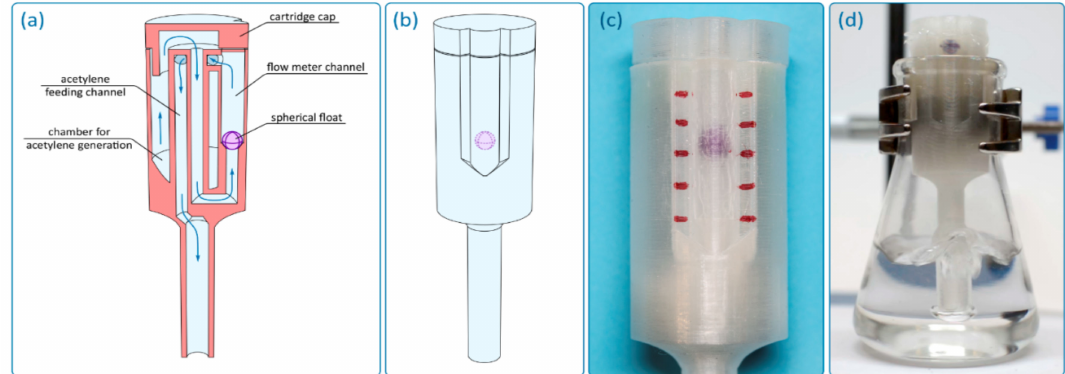
Figure 5. Reactor with an integrated float-type flow meter: ( a ) sectional view of the reactor, illustrating the system of channels through which the gas flow moves (shown by blue arrows); ( b ) general schematic view of the reactor; ( c ) detailed view of the reactor with the float in middle position; ( d ) during the acetylene release, the float moves to the upper part of the flow meter channel.